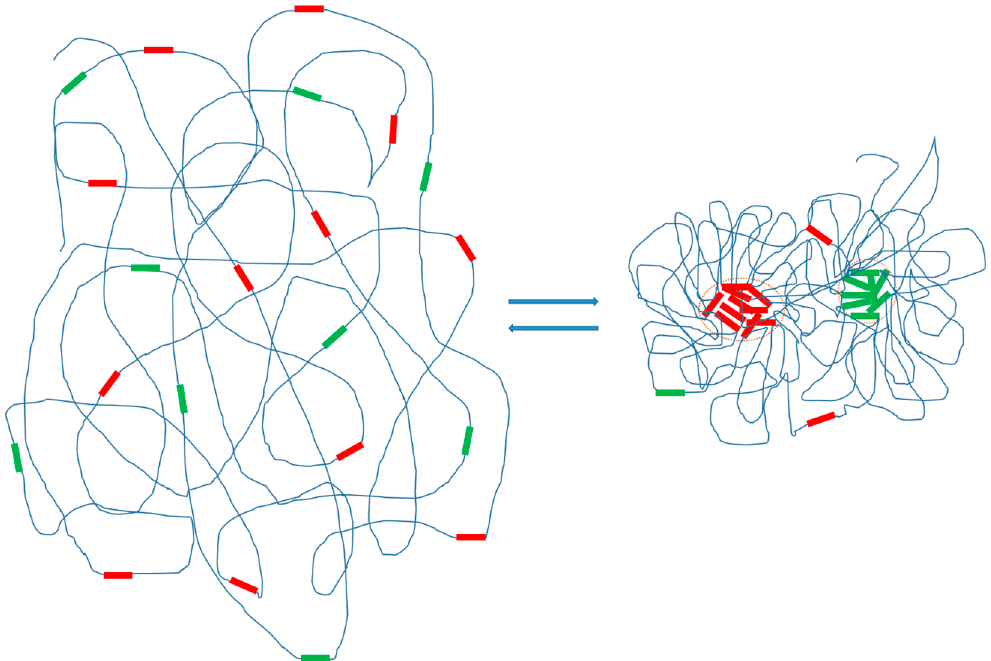
Figure 1. Hypothetical phase separation of DNA repeats in chromosomes. Repeats in two different families (indicated with red and green colors) are used to illustrate the idea of phase transition of repeat DNA in a chromatin segment. Before phase transition (left), the repeats are randomly distributed in the territory of an uncondensed chromosome. After transition (right), repeats are phase-separated from the bulk chromatin and form repeat assemblages (indicated by circles), which likely contain other molecules such as proteins and RNAs. The formation of the assemblages causes chromosome condensation. Assemblages of different repeats may have the potential to merge into bigger chromosomal domains under specific conditions (not shown).